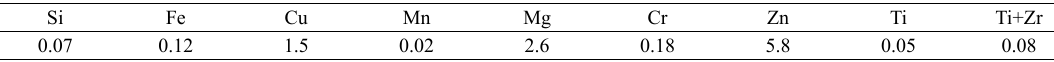
Fig. 1 indicates the stages of the aging process of AA7075. It consists of “dissolution, cooling, and precipitation” steps. In